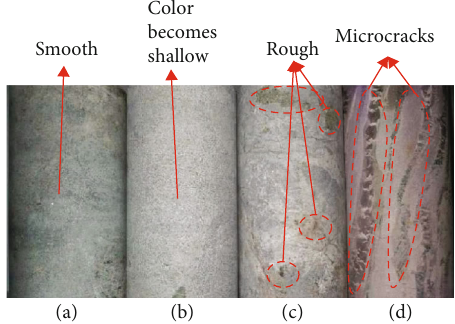
Figure 7: Macrocomparison of rock specimens before and after di ff erent saturations. (a) Naturally dry condition. (b) pH = 7 . (c) pH = 6 . (d) pH = 5